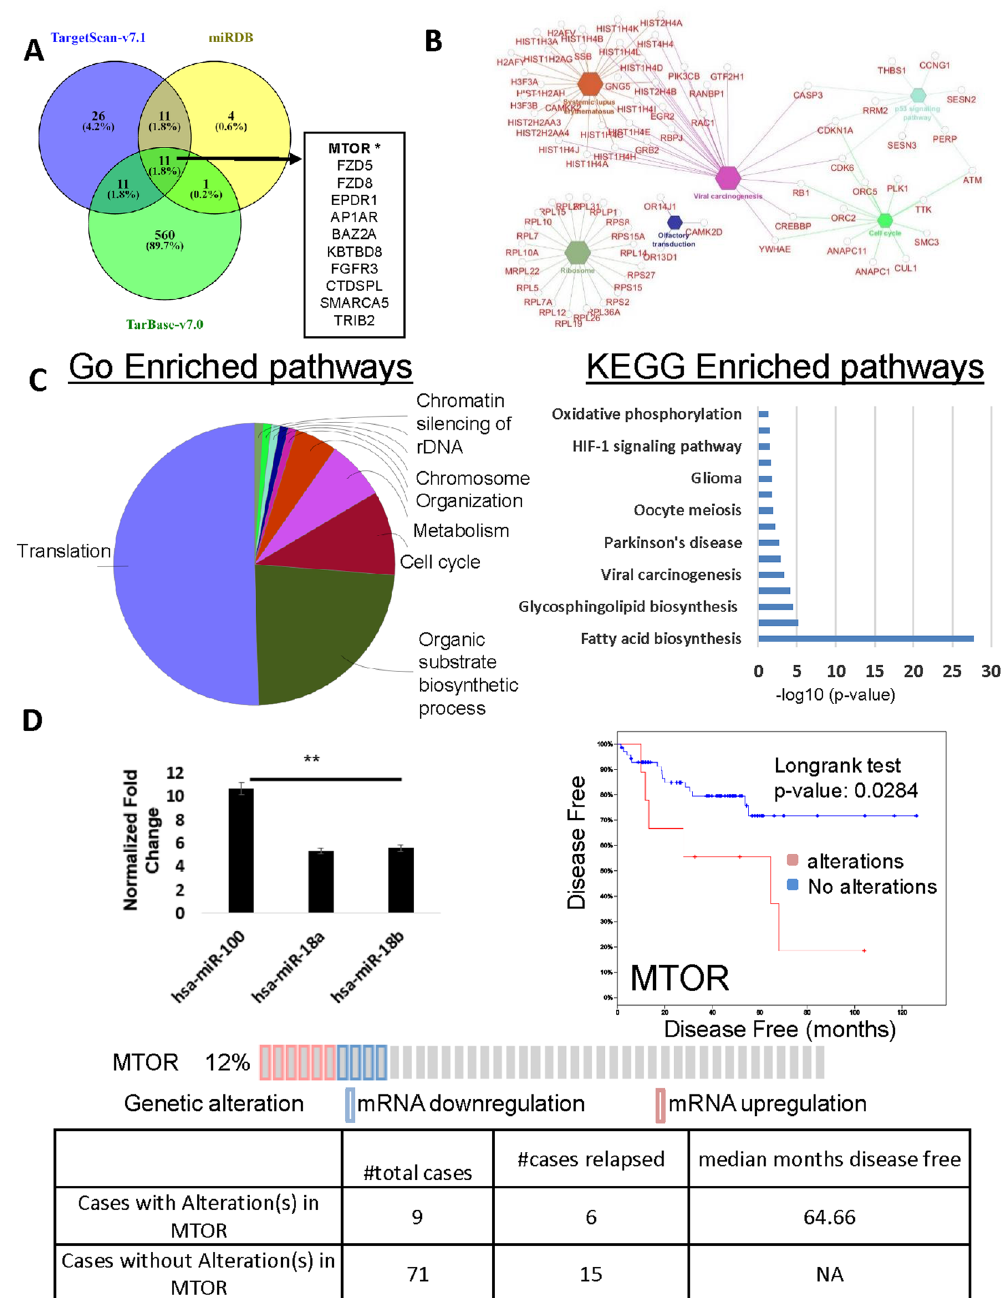
Figure 4. Curated and predicted interaction network for miR-100-5p. ( A ) Three databases were used to find predicted gene and protein interactions with miR-100-5p. ( B ) Enriched canonical pathways using KEGG and GO pathway databases for predicted targets of miR-100-5p. Octagons represent major canonical pathways and associated genes, in red, are presented in round nodes circulating the pathways (generated using Cytoscape). ( C ) Gene networks regulated by miR-100-5p based on canonical pathways from GO and KEGG enrichment analyses associated with genes that are predicted to be regulated by miR-100-5p. ( D ) miR-100-5p expression in Taylor et al . 32 MSKCC database finds a significant correlation between poor survival and alterations in target of miR-100-5p,